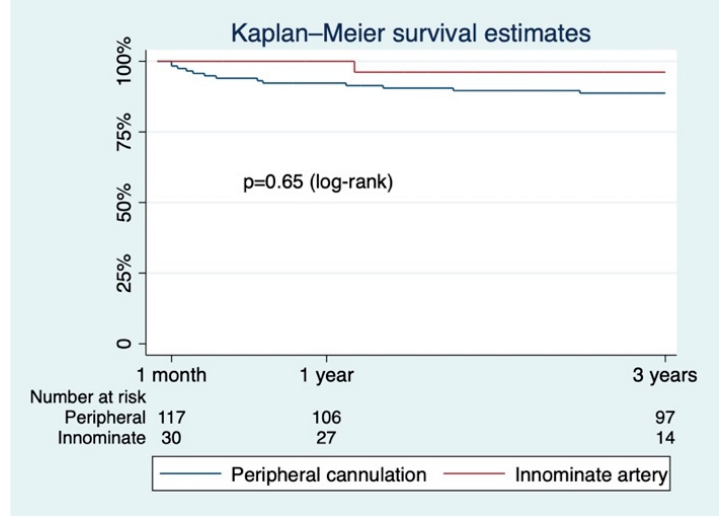
Figure 3. Long-term Kaplan–Meier survival function beyond the acute phase (>30 days).